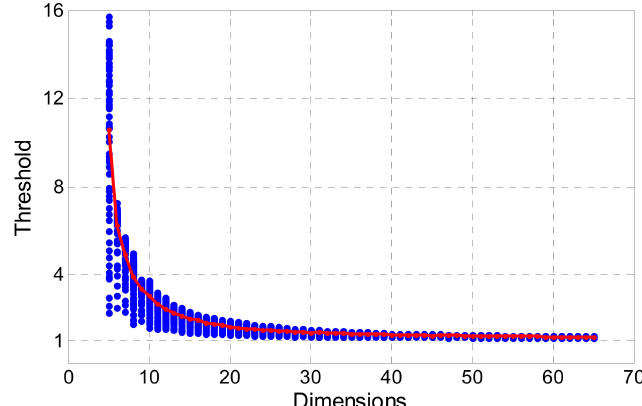
Figure 2. A plot of the threshold under FFRT as function of ambiguity dimension. Blue denotes thresholds calculated at di ff erent BSR values and dimensions; red denotes the mean threshold of each